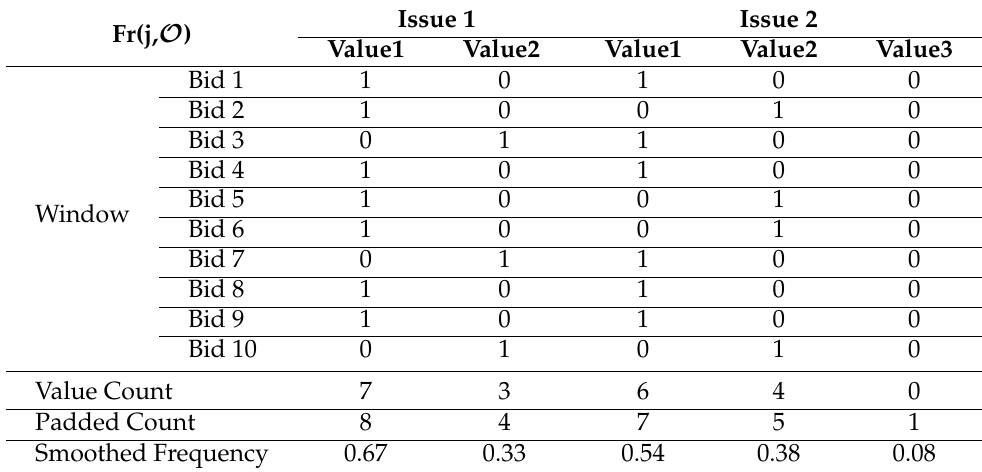
Table 1. Issue values’ smooth frequency calculation given an example window of